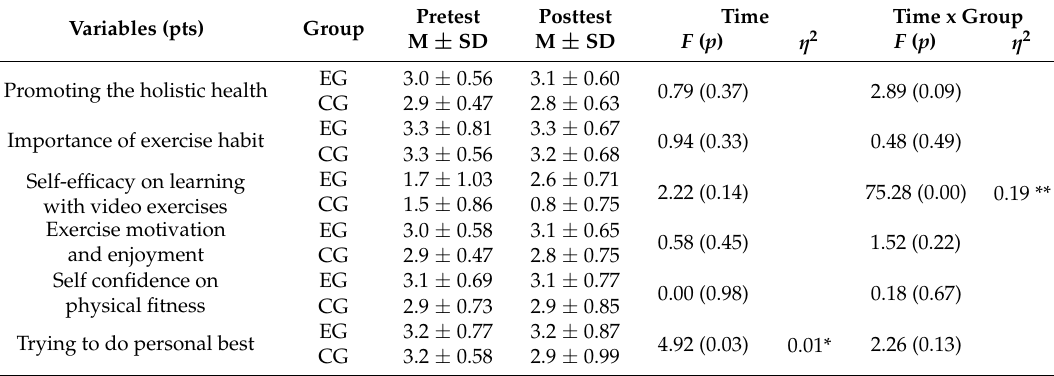
Table 2. Descriptive statistics and results of ANOVA variables before and after the